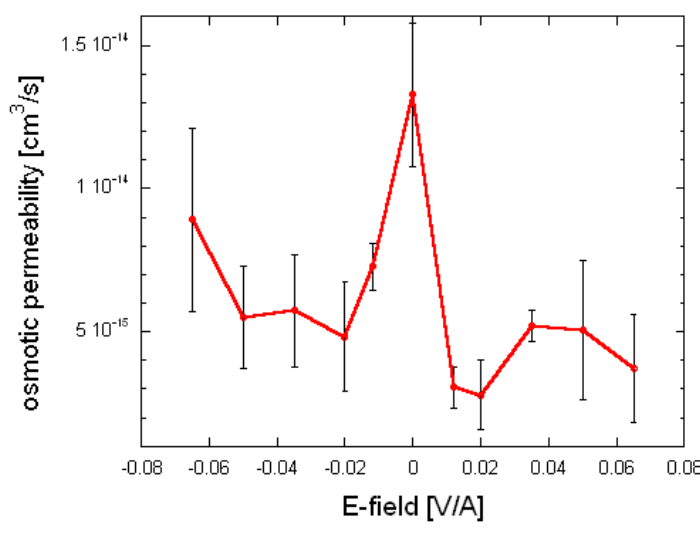
Figure 1. Osmotic permeability for 10 ns static-field pulses along both ± y -axis direction as a function of pulse intensity, along with 100 ns-sampled zero-field results.